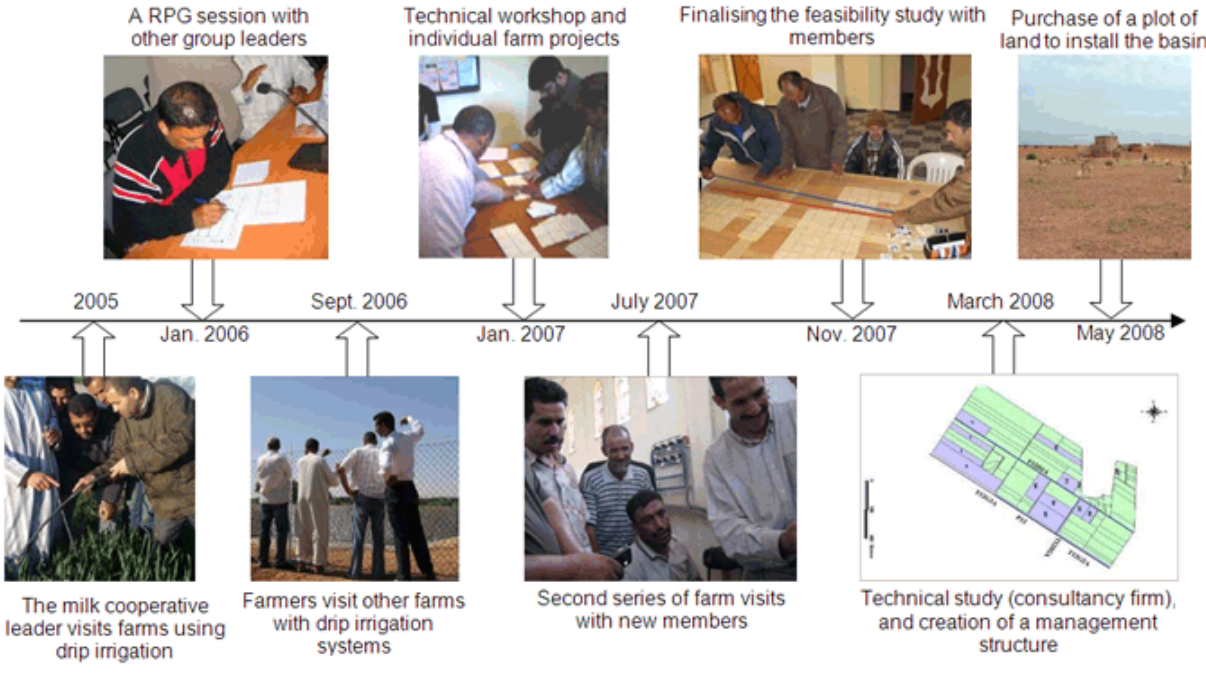
Fig. 2 . Different steps in the design of a joint irrigation project with the members of a milk